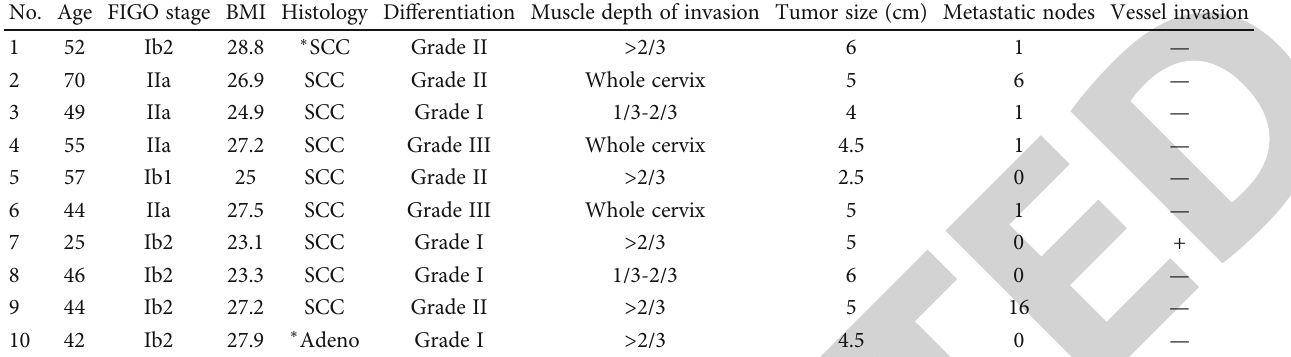
Table 2: Patients with unsuccessful SLN